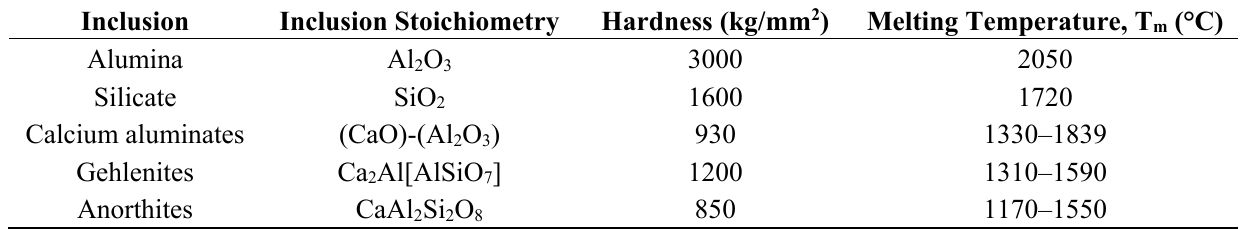
Table 7. Approximate hardness and melting temperature of some common oxides in steels